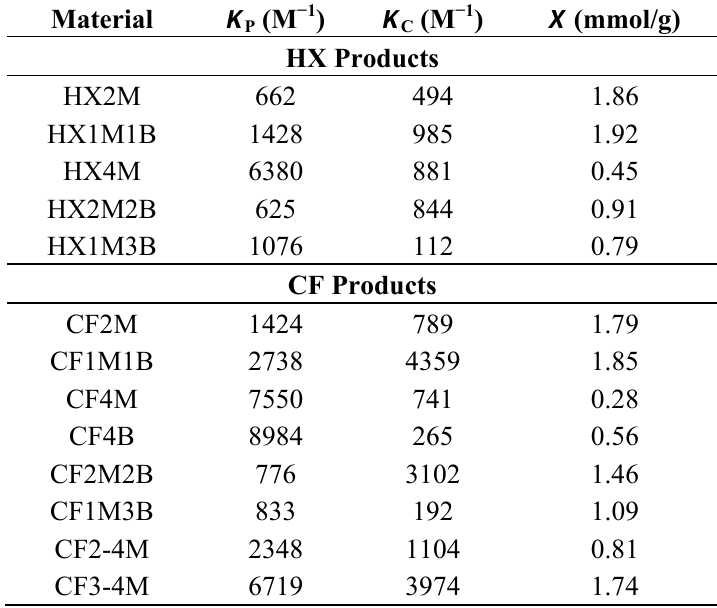
Table 2. Parameters from fits generated for perchlorate binding isotherms. Here, K are the site affinity for perchlorate and chloride, respectively. X is the effective site concentration per gram of